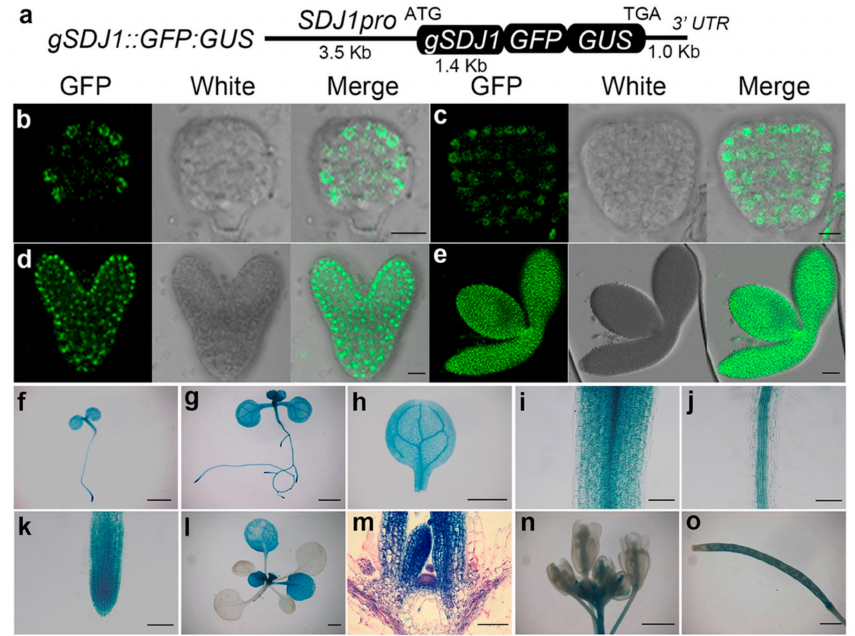
Figure 5. Expression of SDJ1 gene in different organs at different developmental stages. ( a ) Diagram of gSDJ1::GFP:GUS construct. ( b – e ) SDJ1:GFP:GUS fusion protein is expressed at global stage ( b ), heart stage ( c ), and torpedo stage ( d ), and mature stage ( e ) during the embryogenesis of gSDJ1::GFP:GUS plant by GFP fluorescence scanning. ( f – o ) Expression of SDJ1:GFP:GUS fusion protein in 3-day-old seedling ( f ), 7-day-old seedling ( g ), cotyledon ( h ), hypocotyl ( i ), root ( j ), and RAM ( k ) of 7-day-old seedling, 14-day-old seedling ( l ), SAM of 14-day-old seedling ( m ), Flower ( n ), and Silique ( o ) examined by GUS staining. Scale bar= 10 µ m in ( b – d ); 50 µ m in ( e , m ); 1000 µ m in ( f – l , n ) and o; 100 µ m in ( i – k